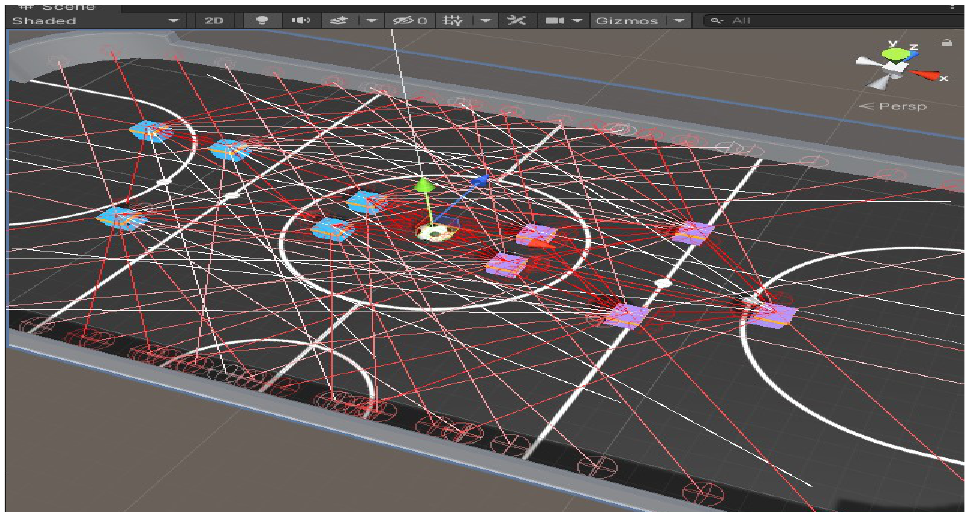
Figure 7. AI gent − player’s pathfinding and ball-searching lines. Figure 7. AI gent - player’s pathfinding and ball-searching lines . Figure 7. AI gent - player’s pathfinding and ball-searching lines .